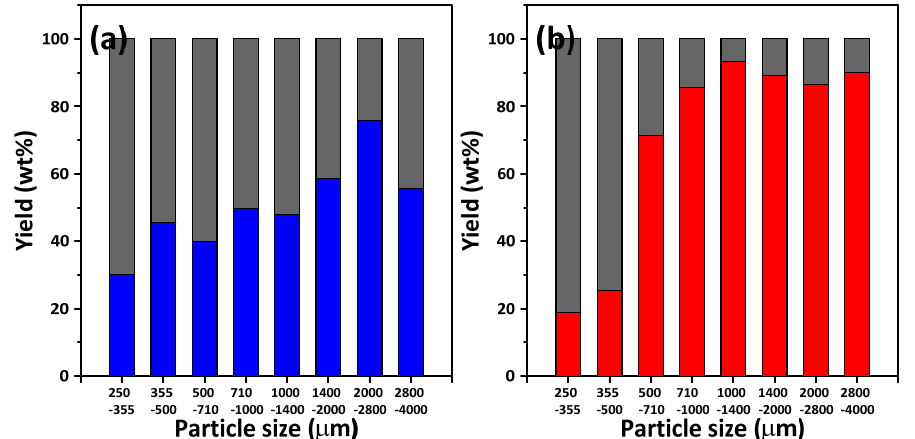
Figure 8. Yield of conductive and nonconductive particles after electrostatics separation for ( a ) the crushed PCB particles (PCB-WT) and ( b ) the crushed PCB particles treated at 300 °C in air (PCB-A300). Gray bar represents nonconductive yield, and red and blue represent conductive yield, respectively.